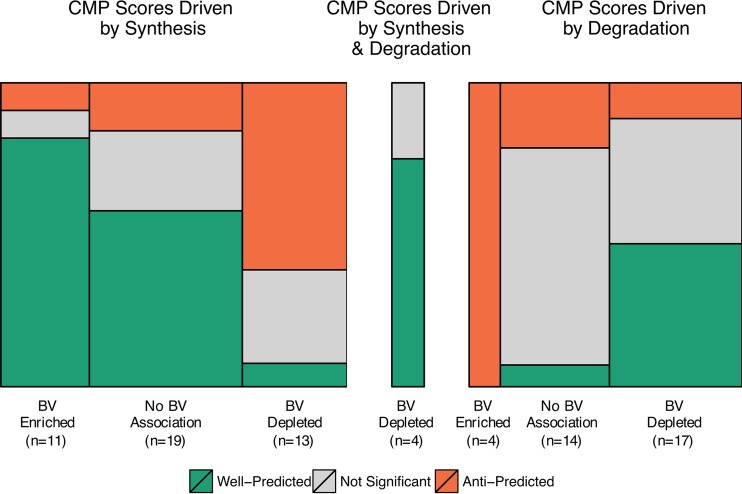
Trends in metabolite predictability in terms of key gene contributors. Area plots depict the numbers of metabolites in data set 1 whose CMP scores are driven by synthesis, by degradation, or by both in relation to their association with the host state and their predictability. The width of each box corresponds to the number of metabolites associated with each host disease state (enriched in BV samples, depleted in BV samples, or neither), and the height corresponds to the number of metabolites that are well-predicted, anti-predicted, or not significantly predicted (also indicated by color). See Fig. S6 in the supplemental material for a similar plot describing metabolite prediction in data set 2.